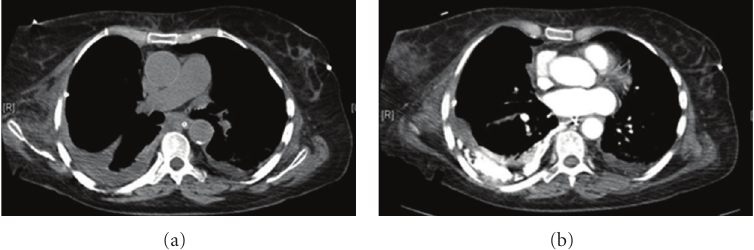
Figure 40: Axial CT scans of the same case as Figure 38 showing entry of water-soluble contrast into the right pleural space following esophageal perforation from an